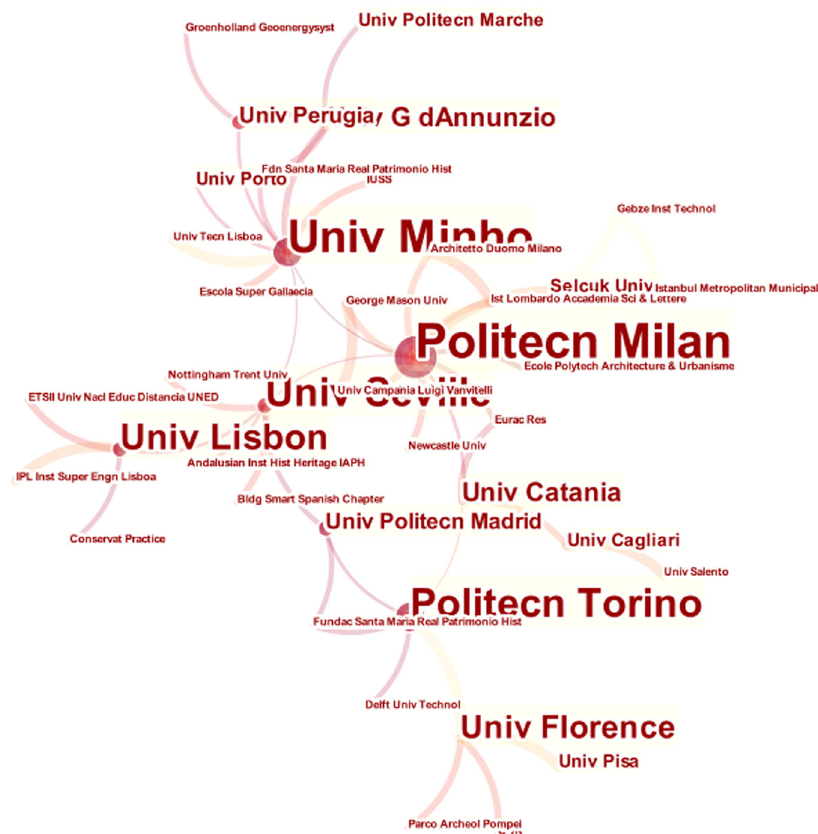
Fig. 5 Institutional distribution of HBIM research. Institutional distribution of HBIM research analyzed by CiteSpace bibliometric analysis software.